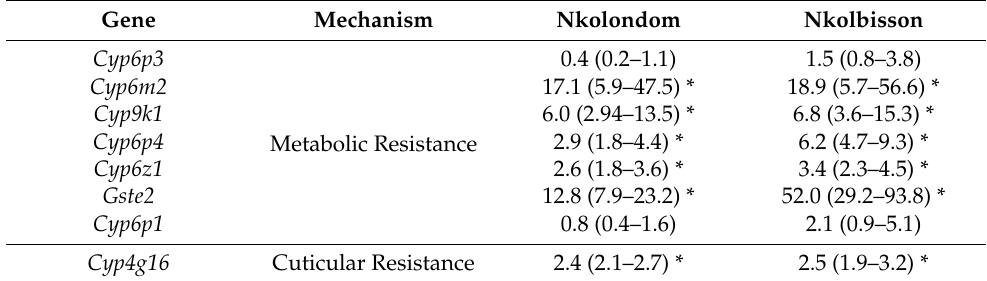
Table 3. Differential expression of metabolic and cuticular resistance genes among the Nkolondom and Nkolbisson mosquito populations as compared with the Kisumu susceptible strain in April 2018. Gene Mechanism